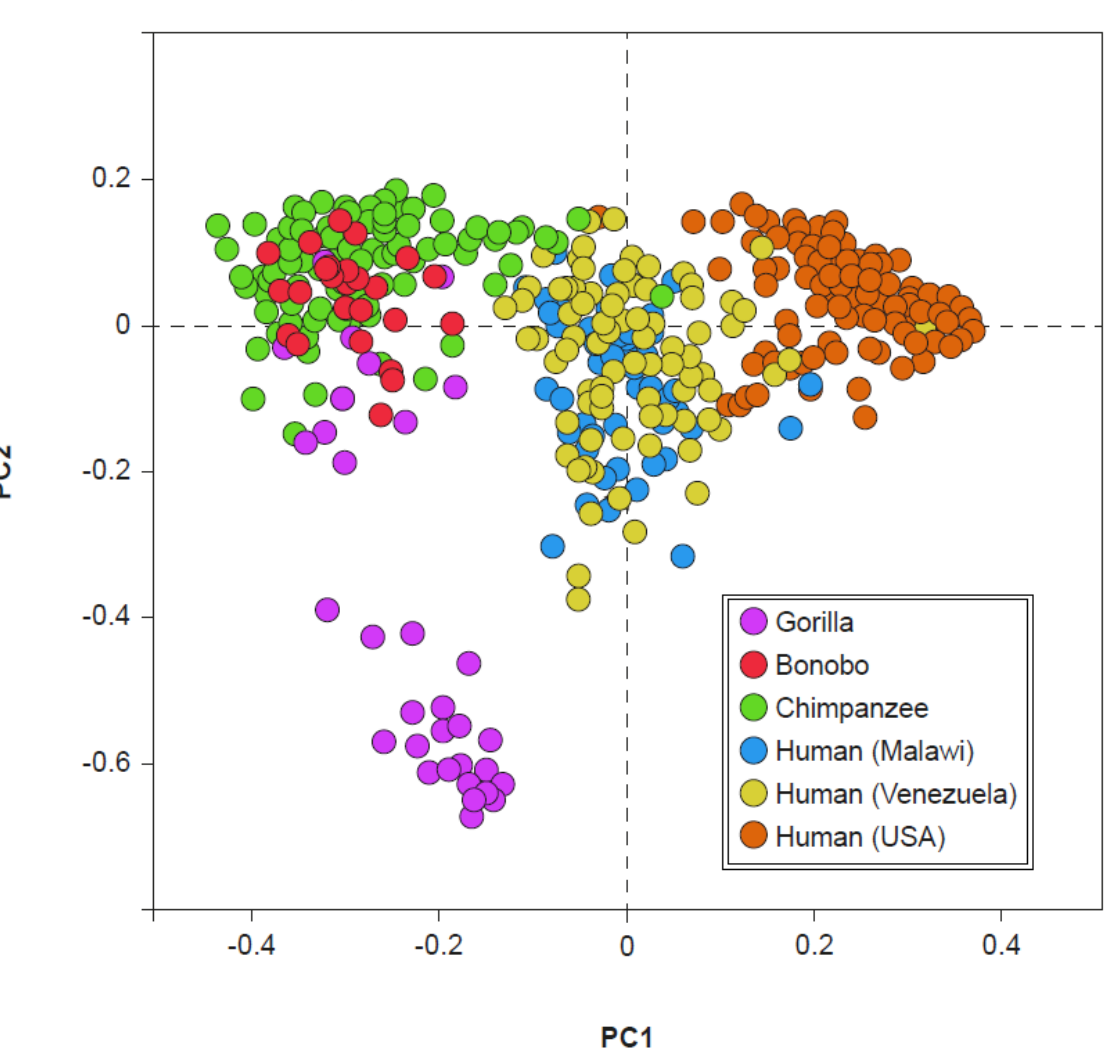
Figure 4. Visualization, through principal coordinates (PC1 and PC2), of gut bacterial consortia of some primates (including humans). Modified from: [47].